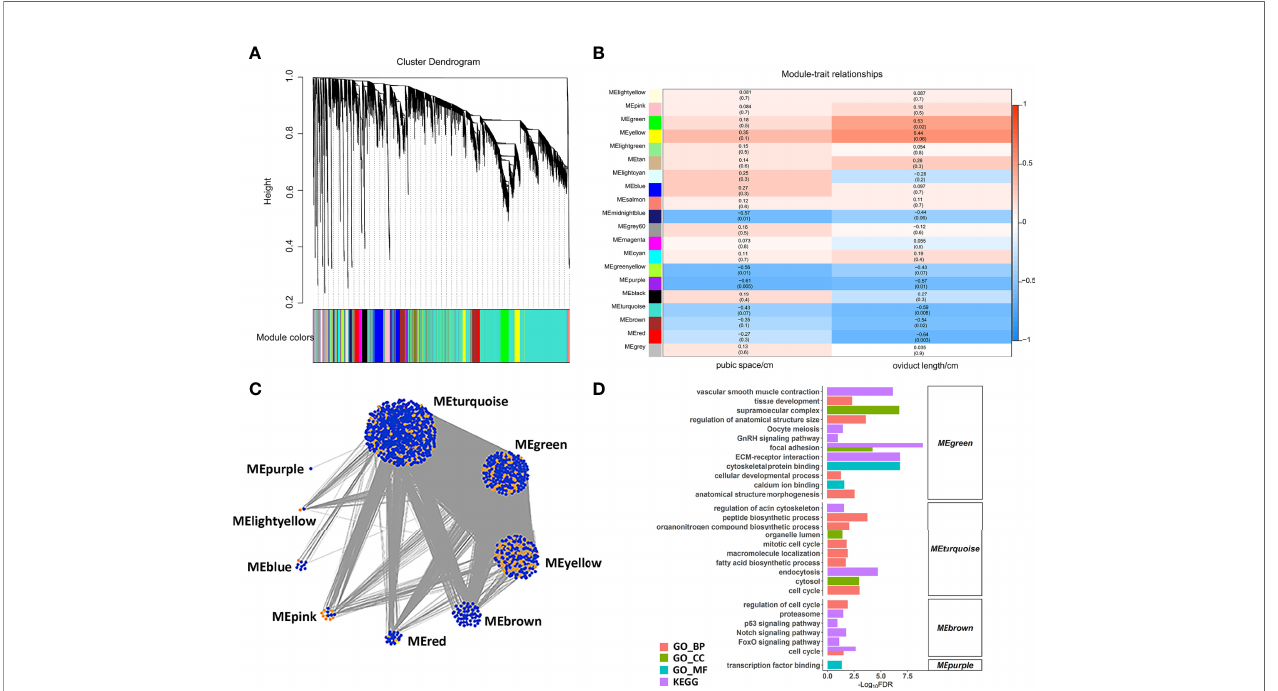
FIGURE 5 | WGCNA analysis of lncRNAs and mRNAs. (A) Hierarchical cluster of 20 modules co-expressed mRNAs and lncRNAs. (B) Module-trait relationships. Each row represents a module eigengene, and each column present a trait. Each module includes the corresponding correlation and P value. (C) The networks of top 1% lncRNAs and mRNAs in nine selected modules. The orange and blue dots represent the hub lncRNAs and mRNAs, respectively. (D) The enriched function of each